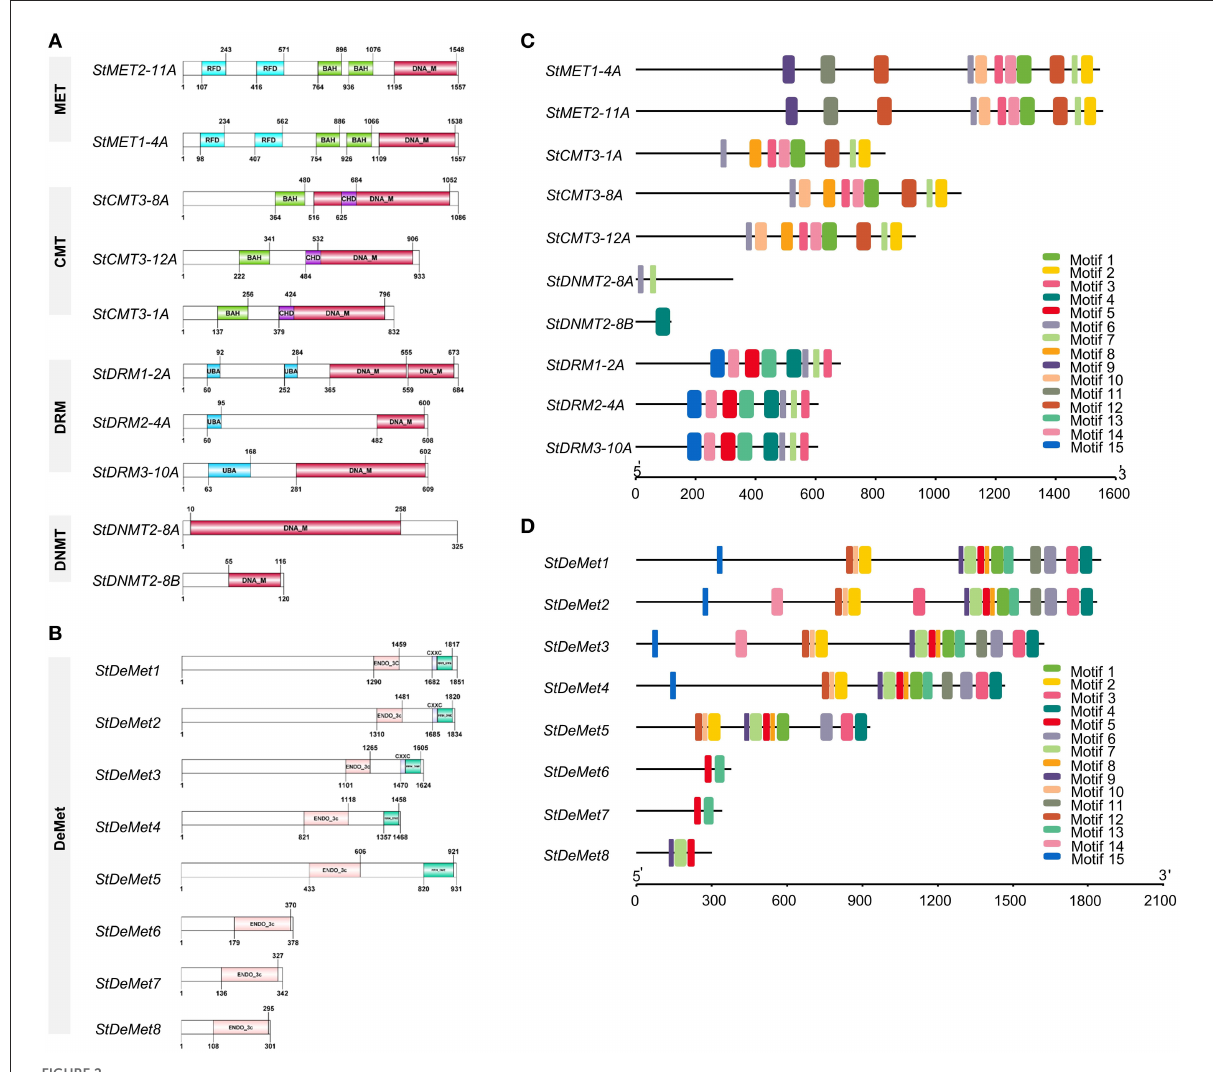
FIGURE2 Schematic structures of conserved domains present in StC5-MTase (A) and StDeMet (B) proteins. The conserved motifs present in C5-MTase (C) and DNA demethylase (D) genes in Solanum tuberosum. (i) The conserved domains in the CMT family possess CHROMO (Chromatin organization modifier) and one BAH (Bromo Adjacent Homology); (ii) MET has two BAH and an RFD domains; (iii) DRM family has a unique UBA domain (Ubiquitin-associated); whereas (iv) DNMT has shorter protein length due to lack of N-terminal regulatory domain. StDeMet